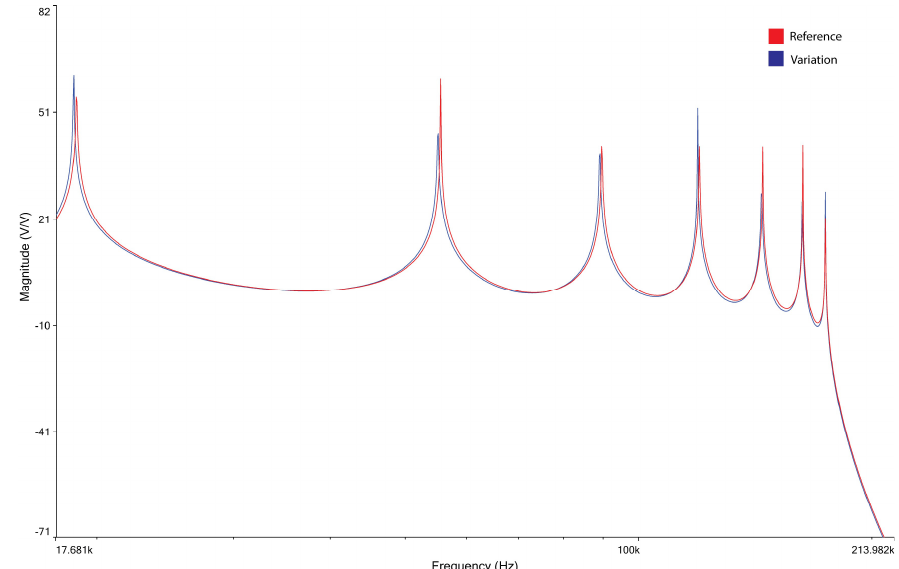
Figure 9. Comparison of the magnitude plots vs frequency of the patterns readable at the seventh node of the L–C L.N. when the capacitance at the 7th cell shifts from 47 nF to 44 nF.